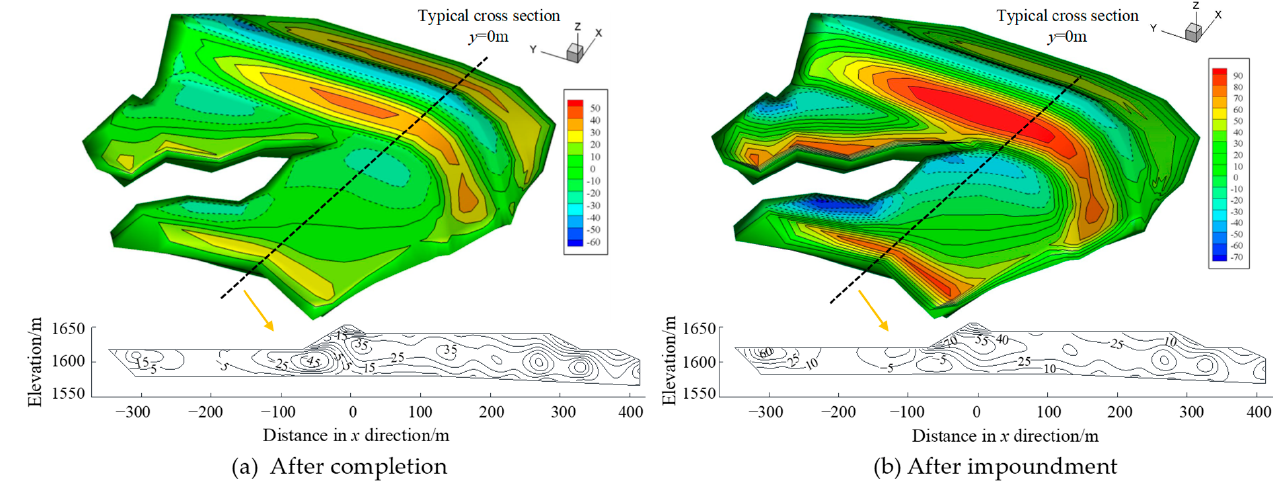
Figure 5. Distribution of horizontal displacement along the river (unit: mm): ( a ) after completion; ( b ) after impoundment.